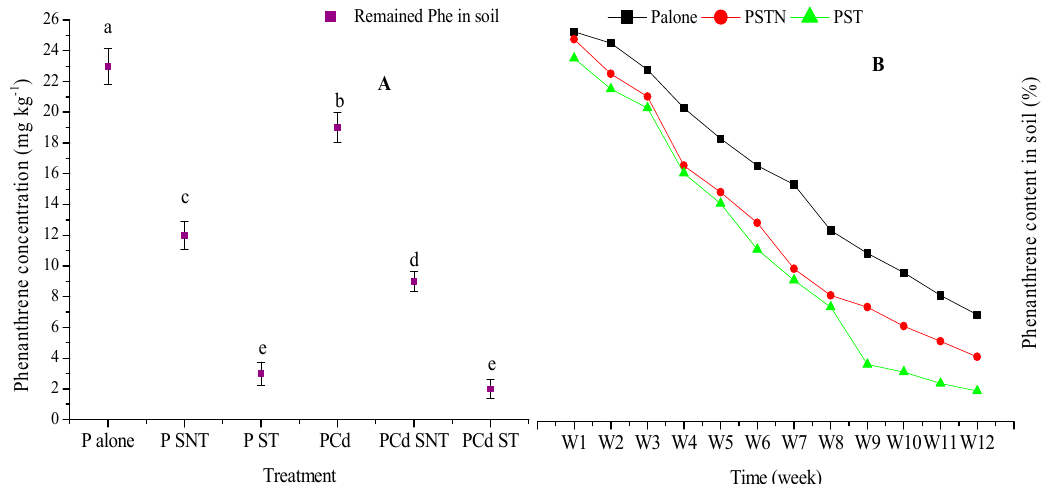
Figure 4. Effect of modified and unmodified rice straw on phenanthrene concentration in soil after 120 exposure days ( A ) and in each week during the 120 experimental days ( B ). Results present the mean of three replicates compared by Tukey’s tests. The lowercase letters indicate a significant difference within different treatments at p < 0.01 and p < 0.05 in A and B, respectively.